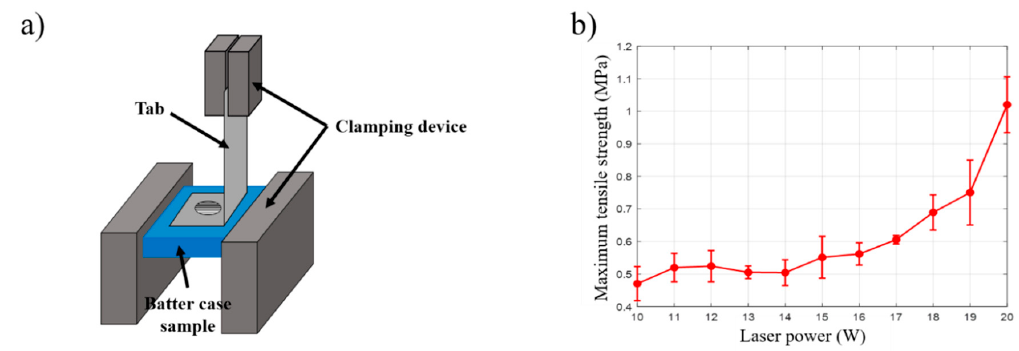
Figure 9. ( a ) Schematic of the tensile test; ( b ) tensile strength of the weld.